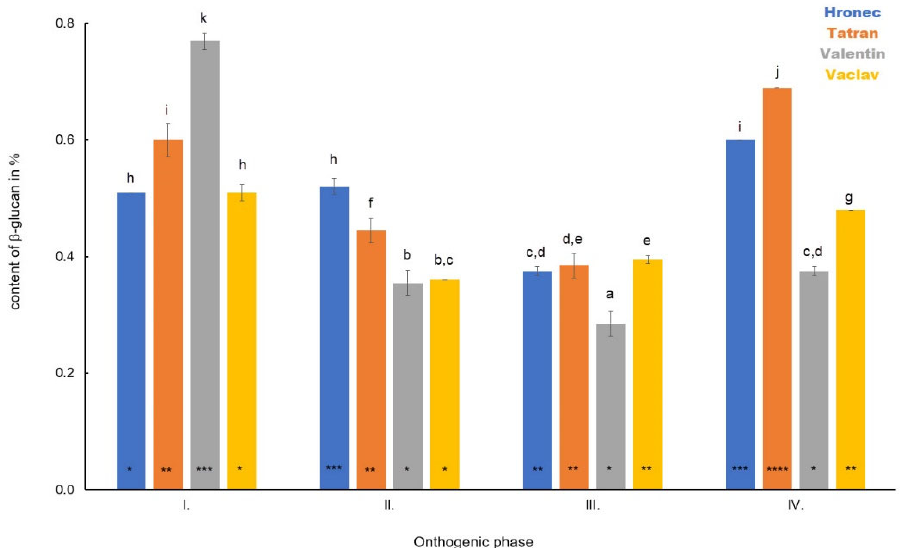
Figure 3. The dynamics in the content of β‐ D ‐ glucan in leaves of four analysed oat varieties during plant development. Different letters indicate a statistically significant difference between individual varieties in specific ontogenetic phase evaluated by ANOVA (LSD, p ≤ 0.05). Star symbols (*, **, ***, and ****) represent statistically significant difference between four varieties evaluated for each monitored ontogenetic phase individually by ANOVA (LSD, p ≤ 0.05).